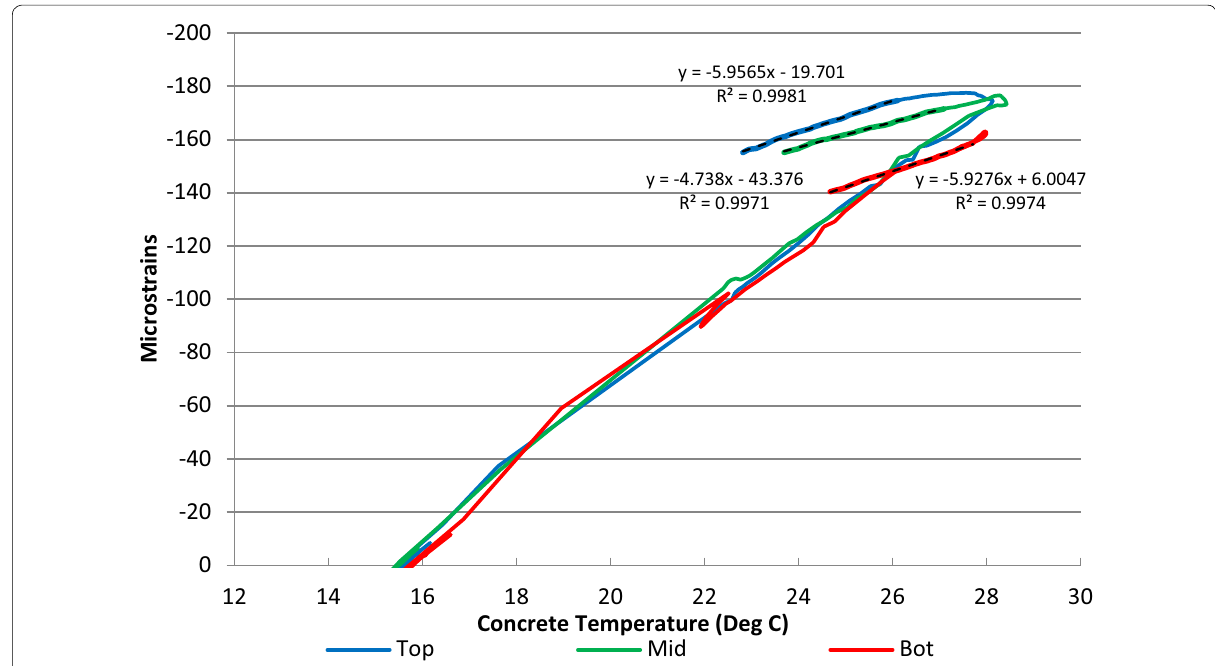
Fig. 14 In situ strain–temperature curve for the in situ topping at one location in the